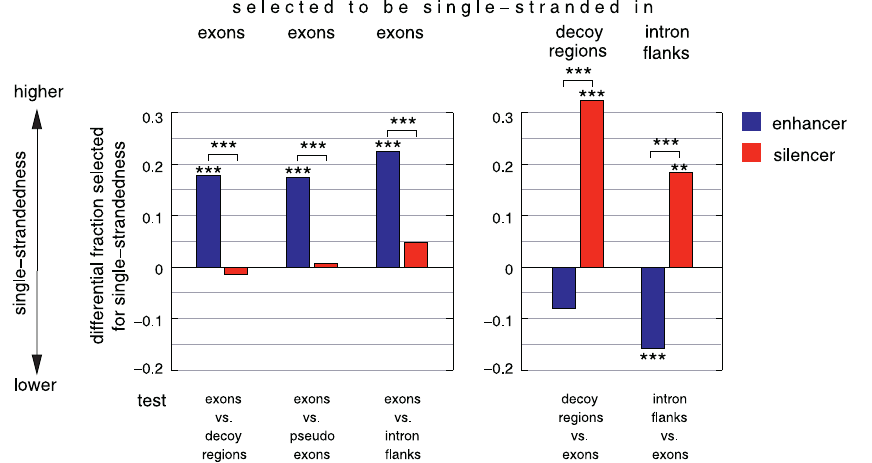
Figure 3. Selection on the Structural Context of Predicted Exonic Enhancer, Silencer, and Splicing-Neutral Motifs The differential fraction of enhancers and silencers that are selected for single-stranded contexts is shown at the y -axis. The differential fraction is the difference between the fraction of enhancers/silencers and the fraction of neutral motifs (background); positive values indicate a preference for single- strandedness. To infer selection for single-strandedness, we compared exons with decoy regions, pseudo exons, and intron flanks ( x -axis). The left side shows the differential fraction of enhancers and silencers that are selected to be single-stranded in exons (more GC rich flanks and higher PU values in exons), the right side the differential fraction in decoy regions and intron flanks (more GC rich flanks and higher PU values in decoy regions and intron flanks). Selection for single-strandedness in pseudo exons cannot be inferred since no enhancer and no silencer motif has more GC rich flanks in pseudo exons. Asterisks above or below bars indicate the significance in a Fisher’s exact test comparing enhancers/silencers with neutral motifs; asterisks above brackets indicated the significance comparing enhancers with silencers (***, p -value , 0.0001; **: p ,